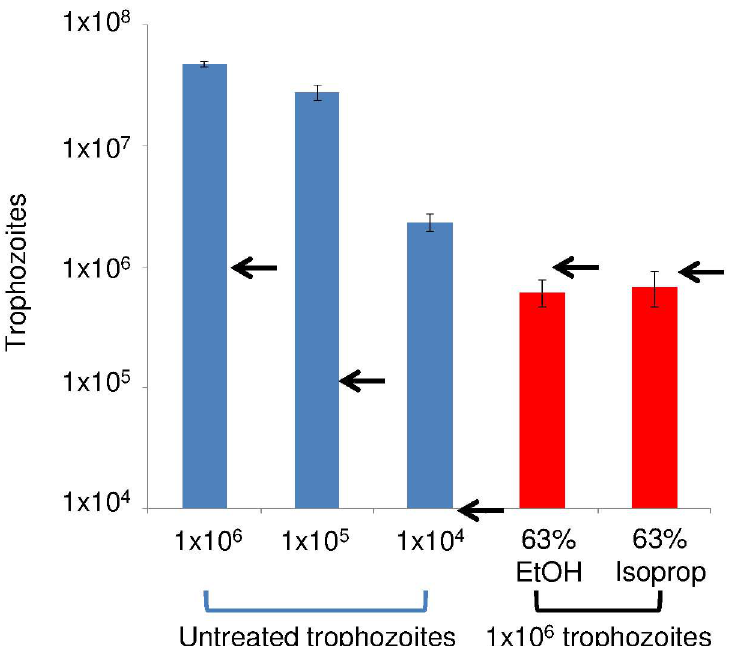
Fig 2. Treatment with alcohols blocks all growth of A . castellanii trophozoites in culture. Log plots of growth in culture shows untreatedtrophozoites (blue), which were undilutedor diluted 10-fold or 100-fold, increasetheir number by 23 to 47 times in culture for three days. In contrast, ethanol-treated and isopropanol- treated trophozoites (red) show no growth in culture, and all of the remaining trophozoitesare dead (as judged by either lack of mobility and lack of acanthopods by DIC or PI labelingby fluorescence microscopy) (previous figure). Plots shown are for A . castellanii MEI 0184 strain, but the same results were obtainedwith the other Acanthamoeba spp . strains and with A . byersi . Arrows indicate numberof trophozoites at start of